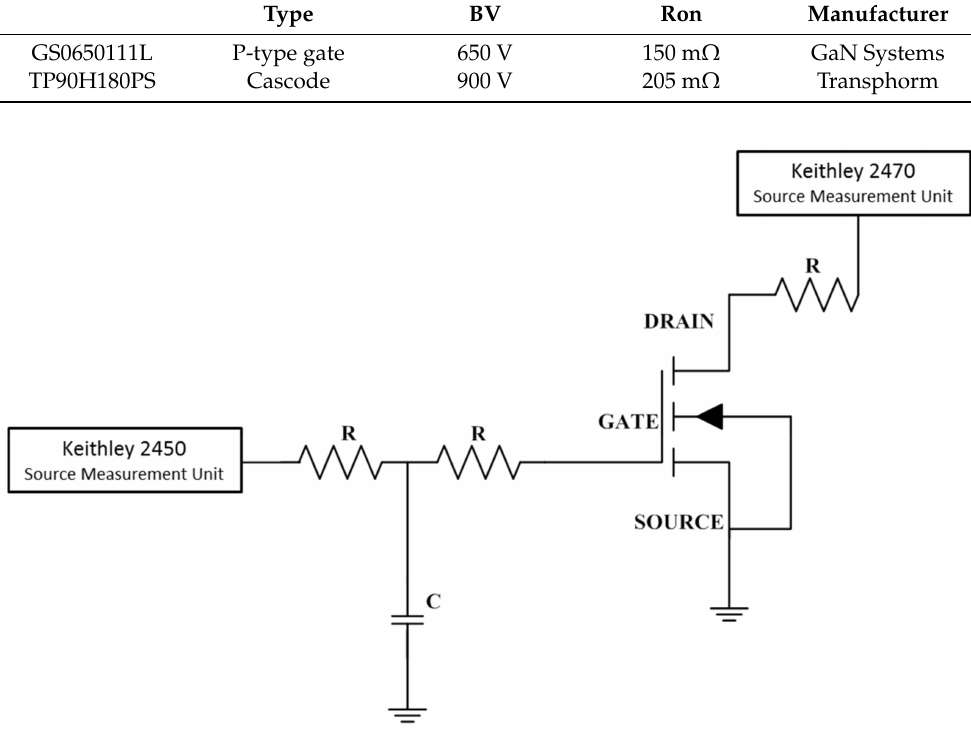
Figure 2. The schematic diagram of the DDD and TID test circuit.